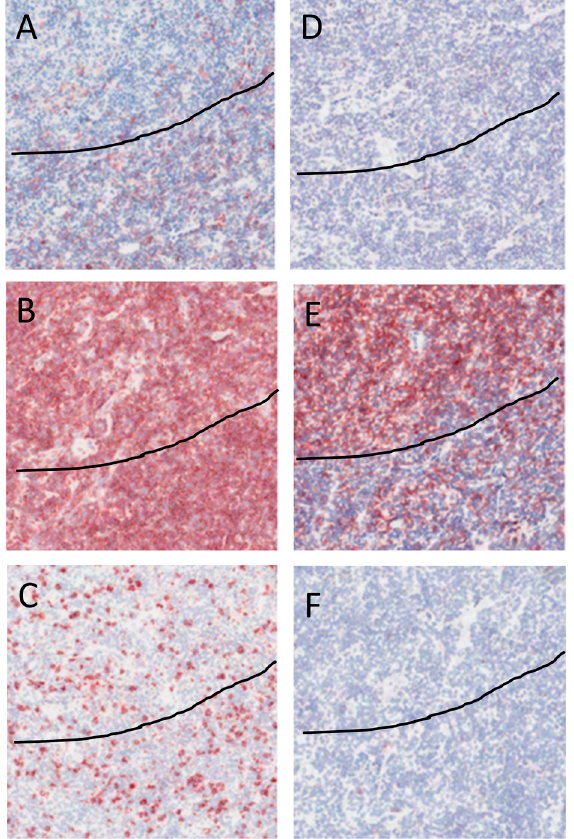
Figure 3. Immunohistochemistry of a representative NLPHL case. All figures show the same area of tumor with magnification 40 × . The line discriminates between the tumor cell rich area, i.e., area above line, from the tumor cell depleted area. Positive staining is visualized in red, counterstaining of the nucleus with hematoxylin is blue. ( A ) CD26+ cells are found mainly outside the tumor area; ( B ) CD4+ cells are scattered all over the tissue; ( C ) CD8+ cells are scattered all over the tissue; ( D ) No expression of Foxp3 in the cells in tumor area, few Foxp3 positive cells are present outside of the tumor area; ( E ) Aggregation of CD69 stained cells in the tumor area; and ( F ) Few CD25 stained cells in the tumor area and out of the tumor area.